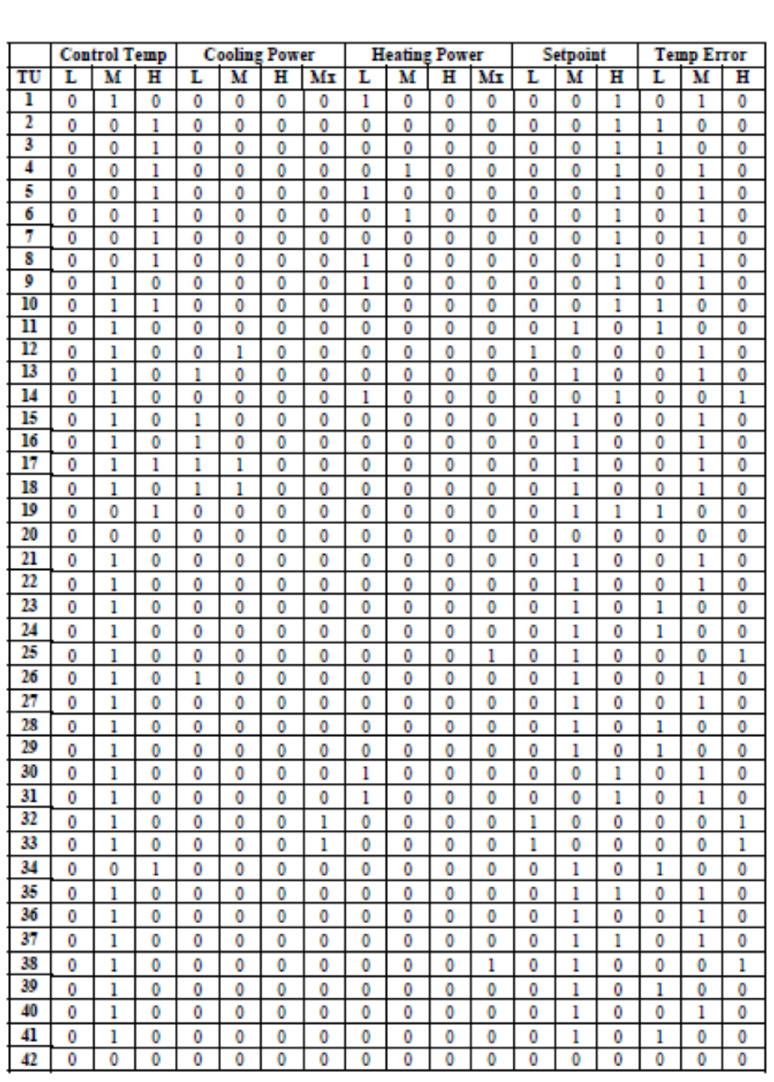
Figure 5. Incidence matrix for the Terminal Units (TUs) on a floor for one 15 min interval. A 1 in a cell indicates that the TU exhibits the behavior represented by the column during that interval.